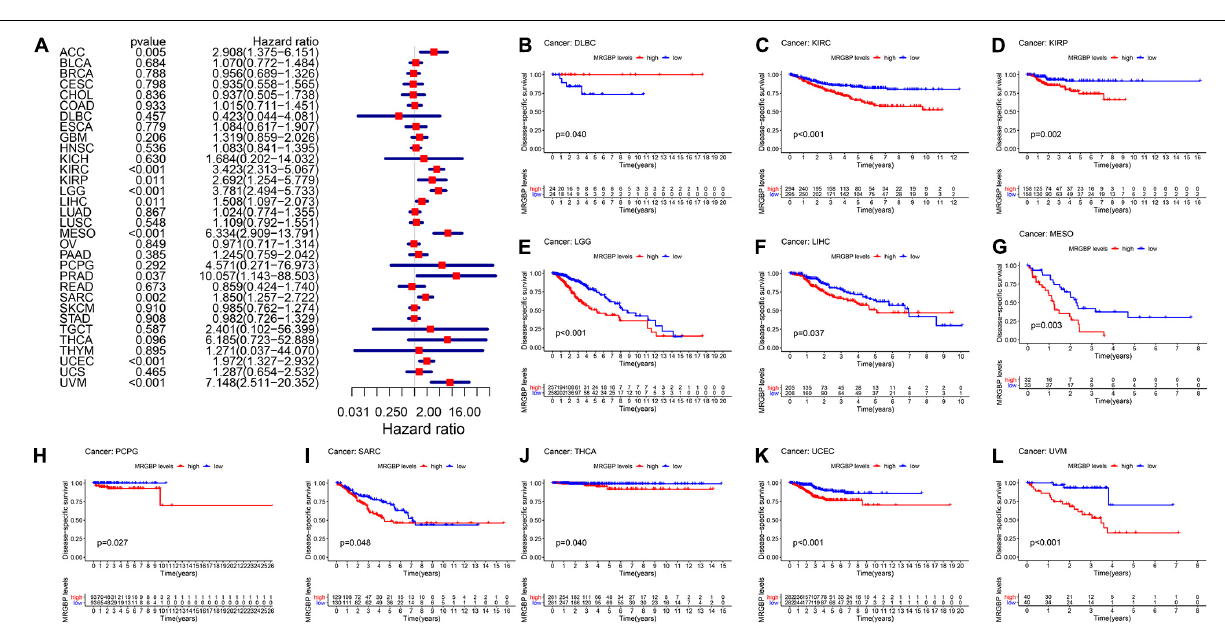
( Supplementary Figure 4 ). It appears that MRGBP expression is higher in patients with stage III and IV than in patients with stage I and II. In addition, the expression of MRGBP in different